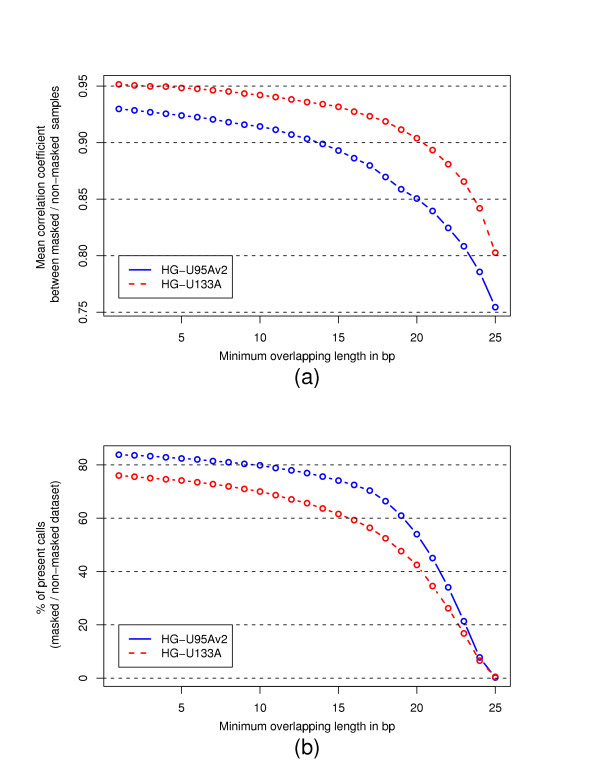
Deviation from the original expression profiles after probe filtering. (a) We compared the modified expression profile of each sample with the original one using the Spearman rank correlation coefficient. The mean correlation coefficient decreases as the minimum overlapping length increases. In addition, the effect of probe filtering is much stronger in U95Av2 than U133A. (b) Percentage of Present calls in the masked dataset compared to the original dataset. It drops down sharply after the minimum overlapping length of around 18 bp.